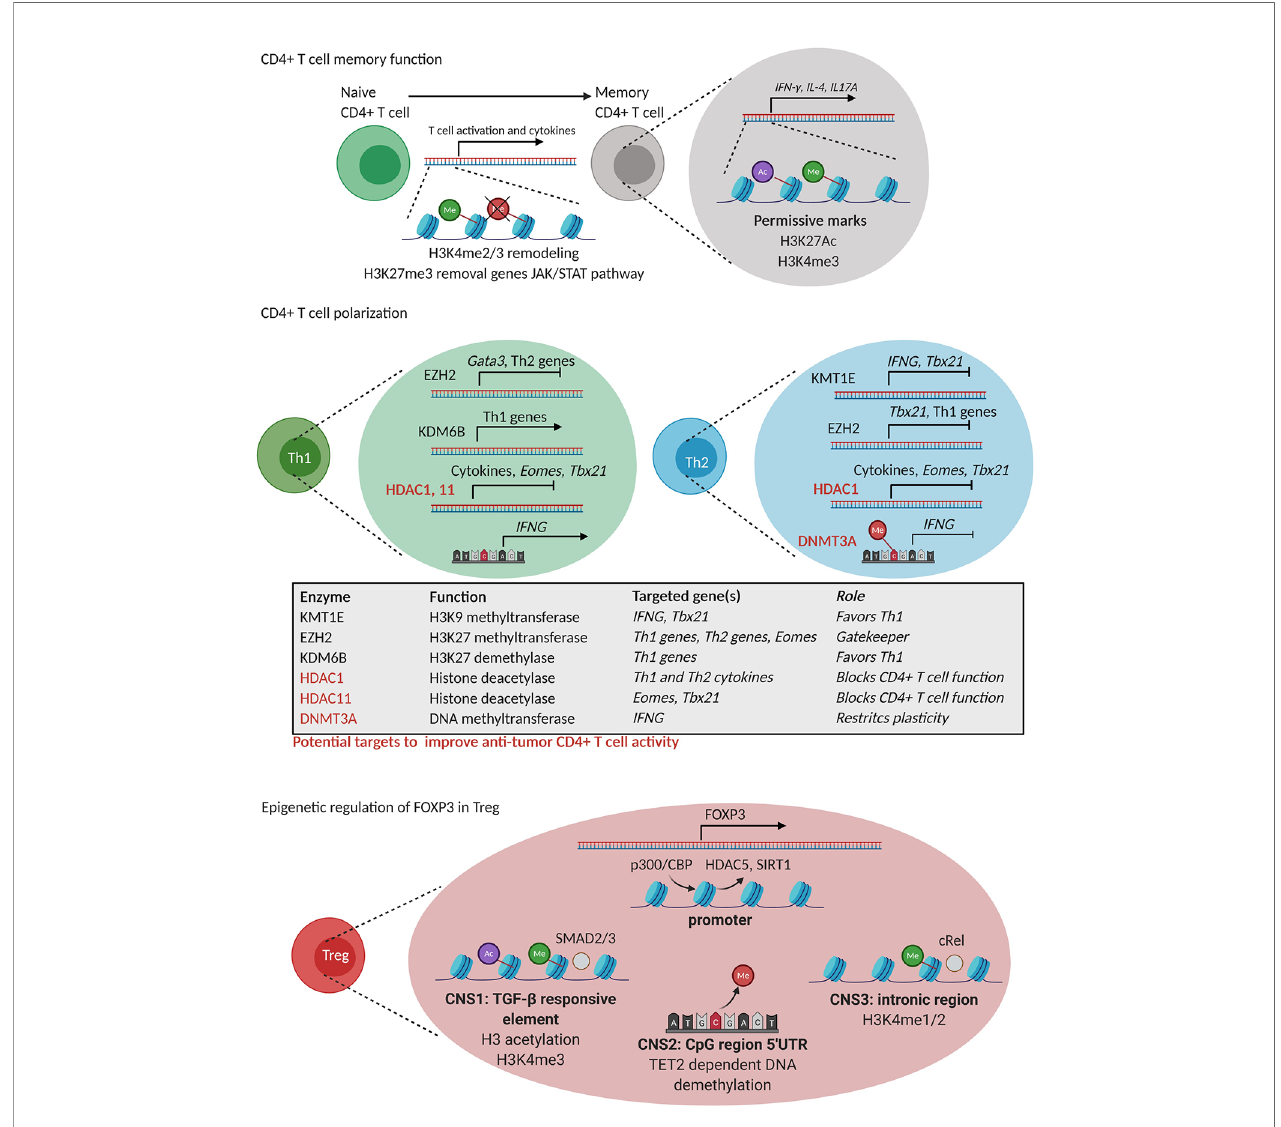
FIGURE 4 | Epigenetic regulation of CD4 + T cell differentiation. CD4 + T cell memory formation : During memory formation, remodeling of H3K4 methylation (green) marks takes place together with the removal of repressive H3K27me3 (red) marks in genes of the JAK-STAT pathway. Moreover, permissive H3K4me3 (green) and H3K27Ac (purple) marks are present in genes related to CD4 + T cell function. CD4 + T cell polarization : T H 1 polarization is controlled by EZH2 that silences T H 2- related genes and vice versa . KDM6B favors T H 1 polarization by positive regulation of T H 1-related genes while KMT1E negatively regulates IFNG and Tbx21 (T-bet) gene expression. HDAC1 and 11 are general inhibitors of CD4 + T cell function through silencing of cytokine production, Eomes and Tbx21 (T-bet). Epigenetic regulation of FOXP3 expression in Treg : FOXP3 expression is regulated by epigenetic processes in Treg including (i) exchange of repressive HDAC5 and SIRT 1 for a permissive CPB/p300 (HAT) complex, (ii) permissive H3K4me3 (green) and H3 lysine acetylation (purple) in a TGF b response element (CNS1), (iii) TET2 dependent DNA demethylation of a 5 ’ UTR region (CNS2), and (iii) H3K4me1/2 poised state of CNS3 needed for Foxp3 expression. HDAC1, 11 and DNMT3A represent potential targets to improve CD4 + T cell anti-tumor